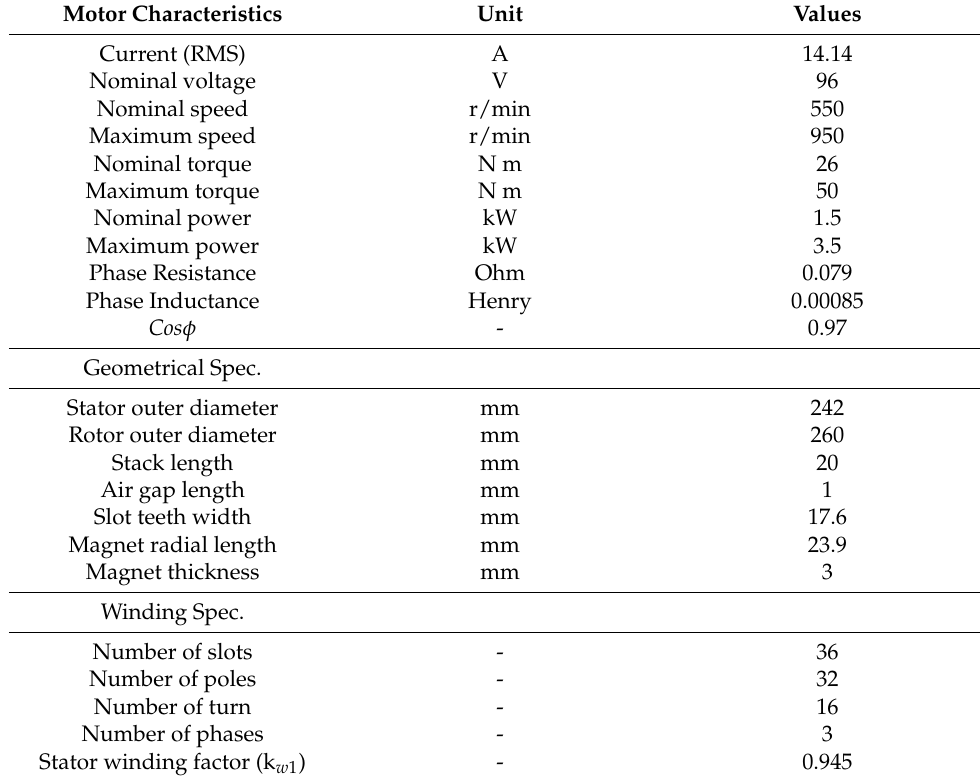
Table 1. Motor Design